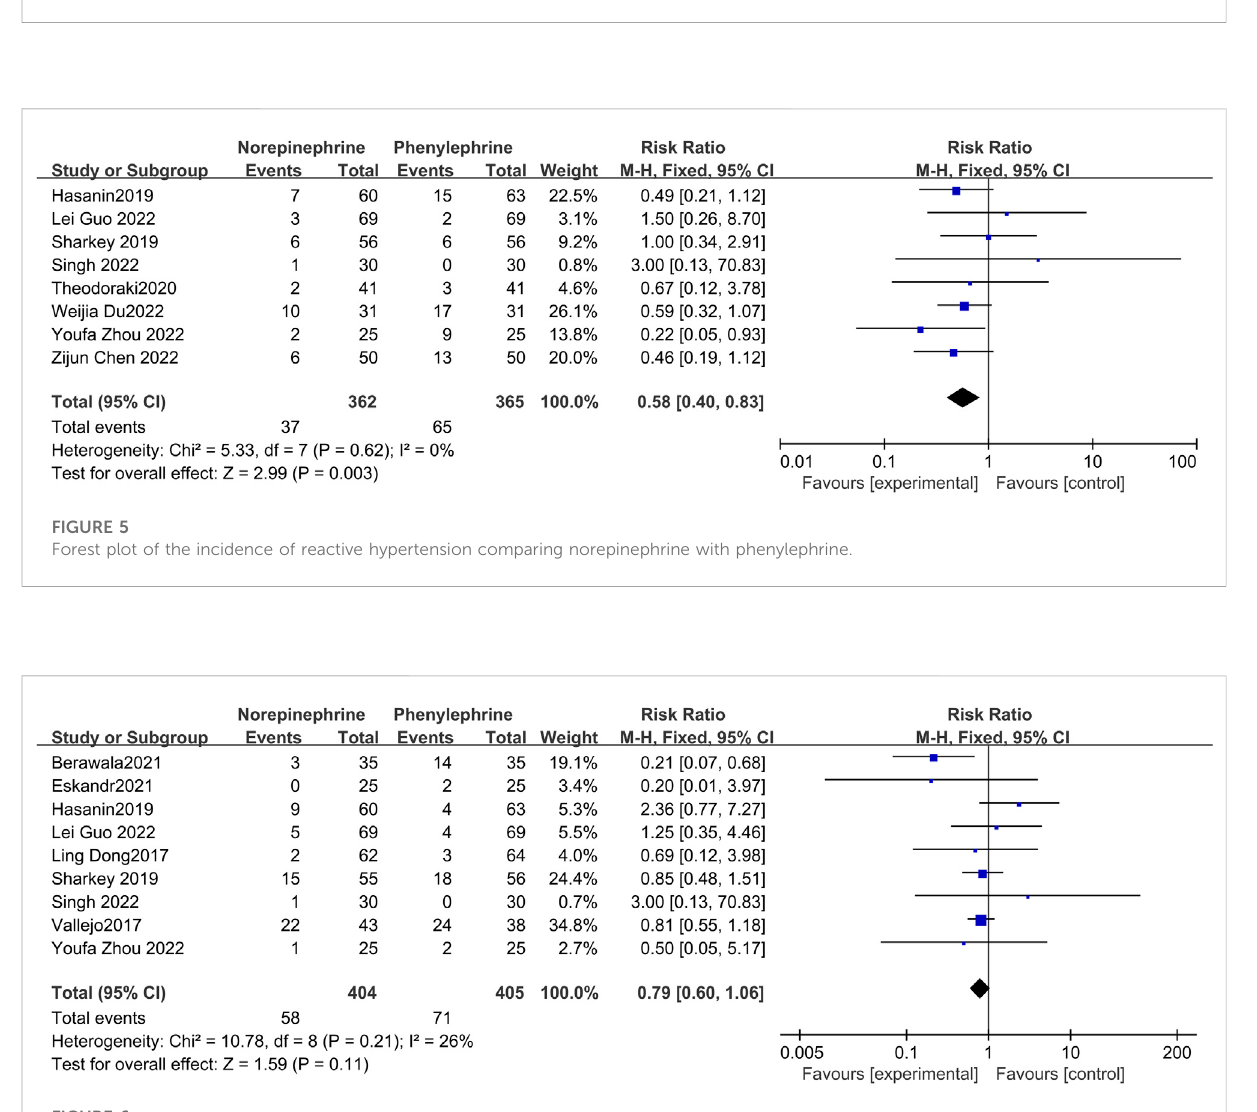
FIGURE 6 Forest plot of the incidence of nausea comparing norepinephrine with